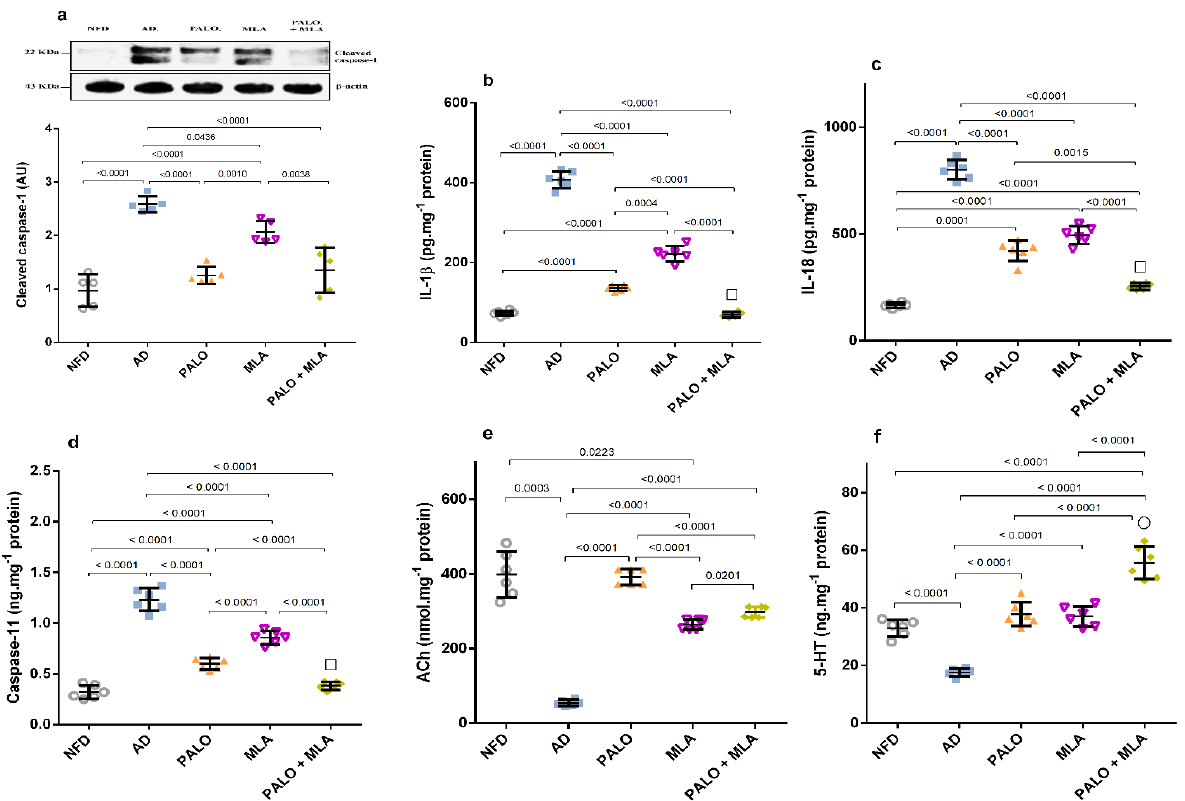
Figure 7. Effect of PALO and/or MLA on hippocampal contents of ( a ) cleaved caspase-1, ( b ) IL-1 β , ( c ) IL-18, and ( d ) caspase-11, as well as ( e ) ACh and ( f ) 5-HT in HFFD/LPS-induced AD model. Values are shown in scatter plots and expressed as mean ± SD ( n = 5–6/group). Panel ( a ) depicts representative cropped blot of cleaved caspase-1 and its densitometric analysis ( n = 5/group). Cleaved caspase-1, caspase-11 and 5-HT were analyzed using one-way ANOVA